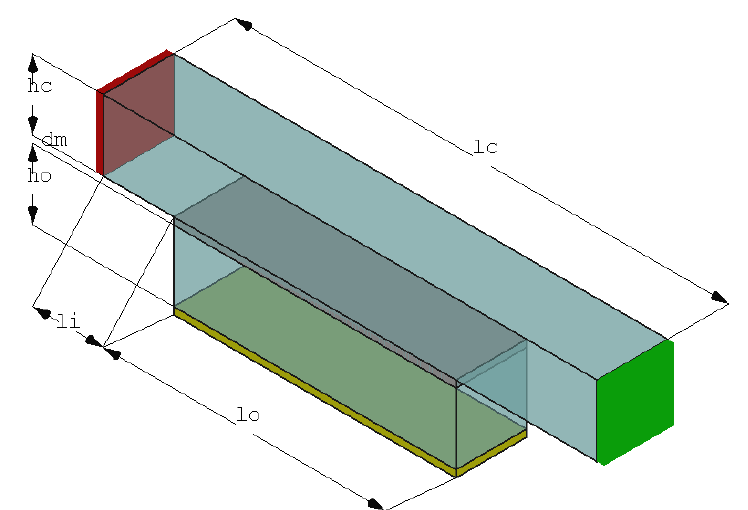
Figure 2. Computational setup: membrane in gray, feed inlet in red ( Γ in ), retentate outlet in green ( Γ out , ret ), and permeate outlet in yellow ( Γ out , perm